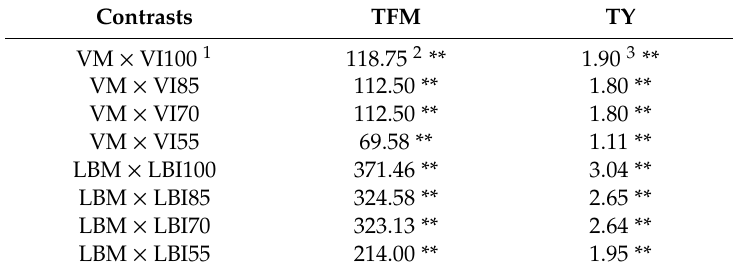
Figure 3. Total fresh mass ( = commercial) of ‘Vanda’ and total fresh commercial mass of ‘Lucy Brown’ as a function of the population density of the cucumber. ◊ ‘Vanda’; □ ‘Lucy Brown’ Total; ▲ ‘Lucy Brown’ Commercial. * p ≤ 0.05 in F test. Table 4. Groups of contrasts for total fresh mass (TFM) and total yield (TY) of ‘Vanda’ and ‘Lucy Brown’ lettuces between additional treatments (‘Vanda’ and ‘Lucy Brown’ monocultures) and factorial (2 lettuces × 4 densities of cucumber in the